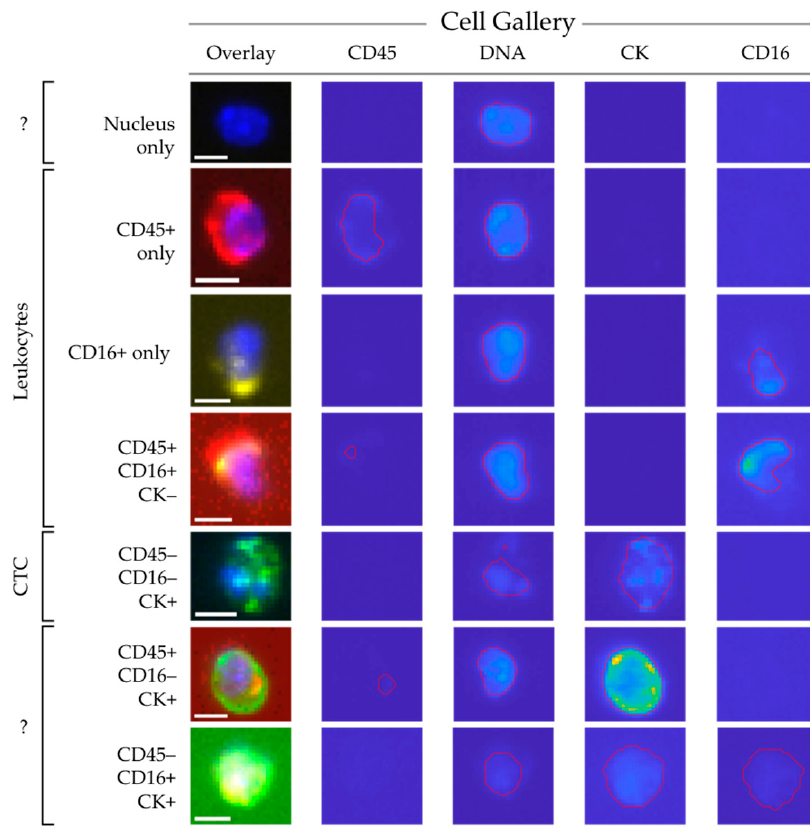
Figure 4. ACCEPT gallery showing cells from all classifications using the presence or absence of several markers. The scale bar is 10 pixels, representing 6.4 µm.